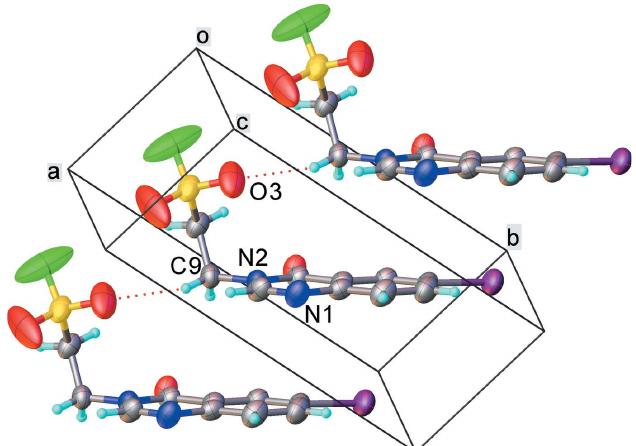
Figure 3 (cid:2) – (cid:2) stacking in the structure of (I).